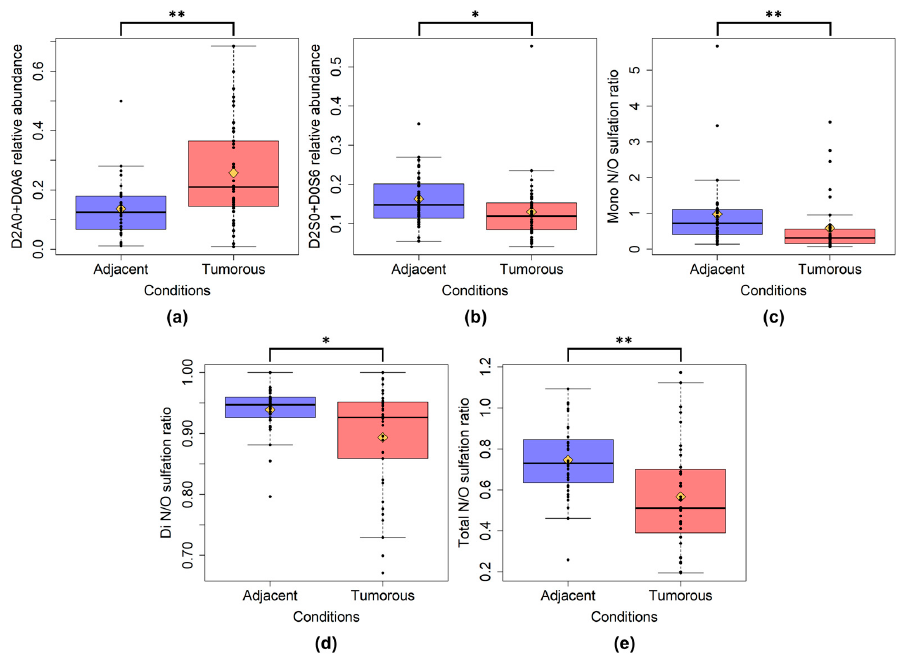
Figure 3. Box plots of altered HS characteristics between all adjacent and all tumor samples. ( a ): D2A0 + D0A6 relative abundance; ( b ): D2S0 + D0S6 relative abundance. ( c ): mono N / O -sulfation ratio; ( d ): di N / O -sulfation ratio; ( e ): total N / O -sulfation ratio. Mono-, di-, and total N / O